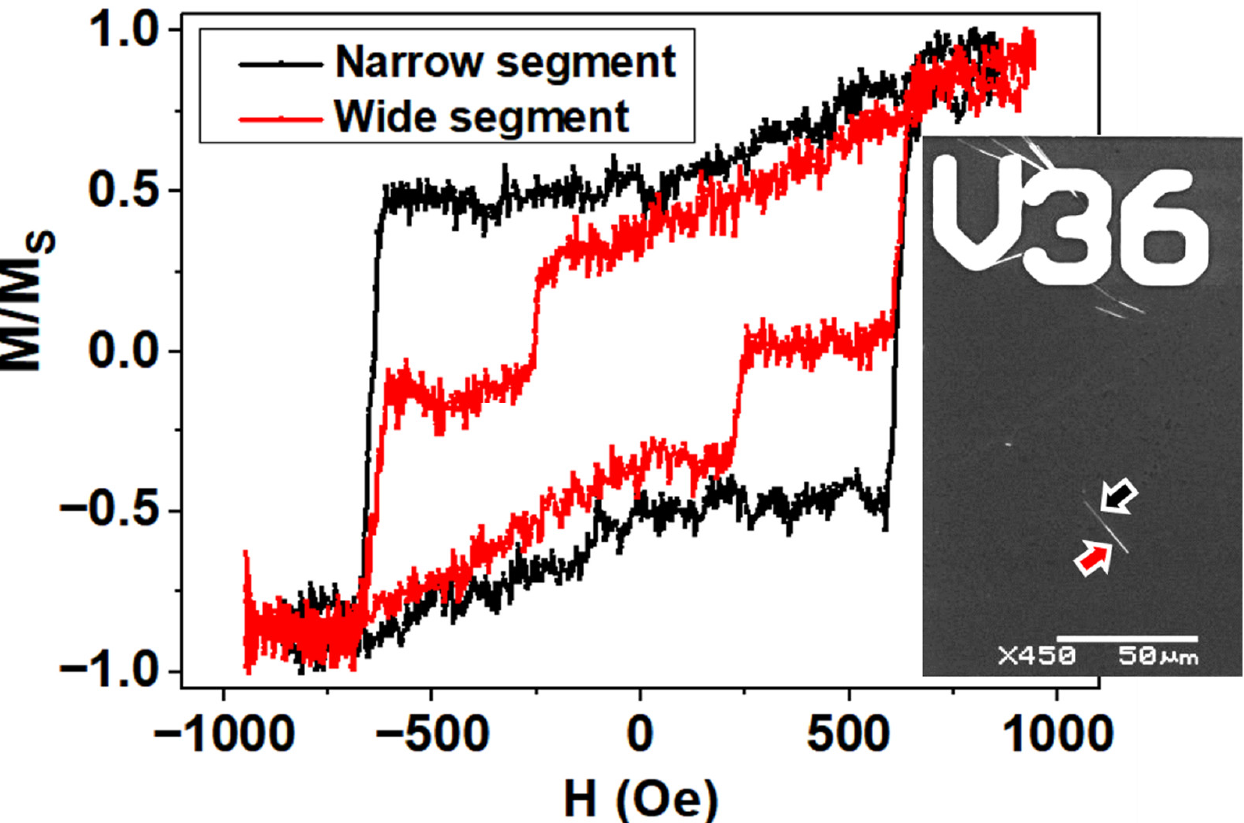
Figure 5. MOKE Hysteresis Loops measured on the narrow (black) and wide (red) segment of single bisegmented FeCo nanowires with the applied magnetic field along the nanowires long axis: The inset shows a SEM image of the measured nanowire highlighting the narrow (black arrow) and wide (red arrow) segments.